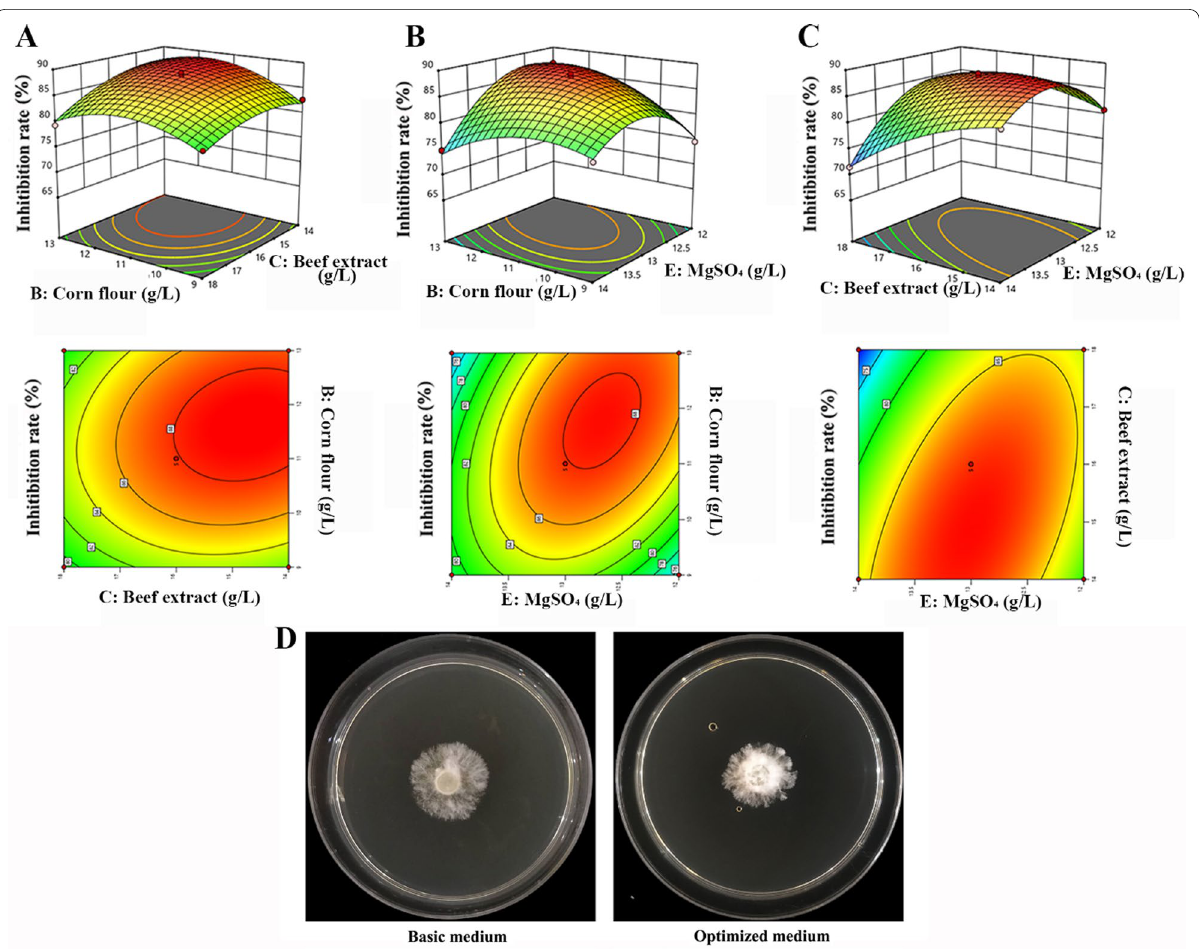
Fig. 2 Response surface plots of the effect of various factors on the inhibition rate of S. sapinea growth by fermented filtrate of B. pumilus HR10 and validation of the optimal formulation. A The response surface and contour plots for the effects of corn flour and beef extract on inhibition rate at middle level of MgSO 4 contents; B The response surface and contour plots for the effects of corn flour and MgSO 4 on inhibition rate at middle level of beef extract contents; C The response surface and contour plots for the effects of beef extract and MgSO 4 on inhibition rate at middle level of corn flour contents; D Validation of the optimal formulation for the inhibition rate of S. sapinea growth by fermented filtrate of B. pumilus